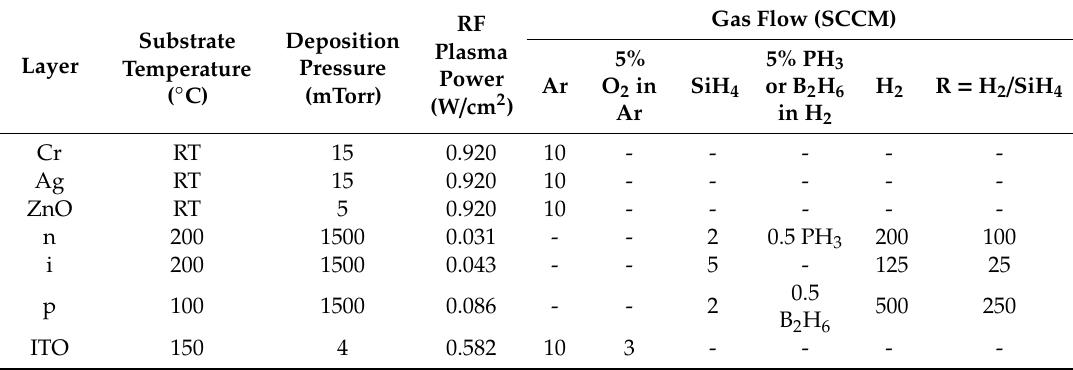
Table 1. Deposition conditions for the individual layers in the nc-Si:H n-i-p solar cell